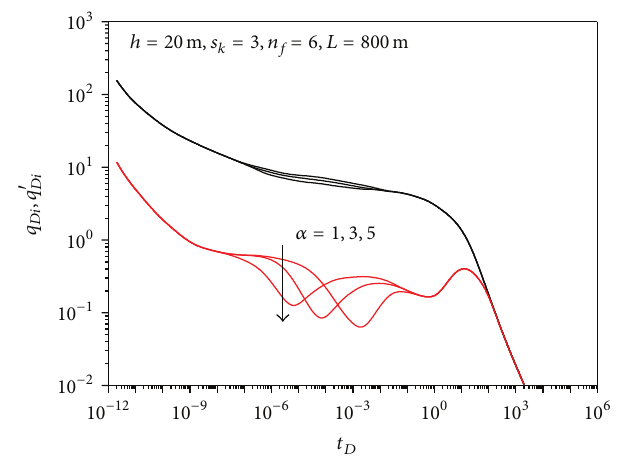
Figure 7: Effect of absorption index on type curves.